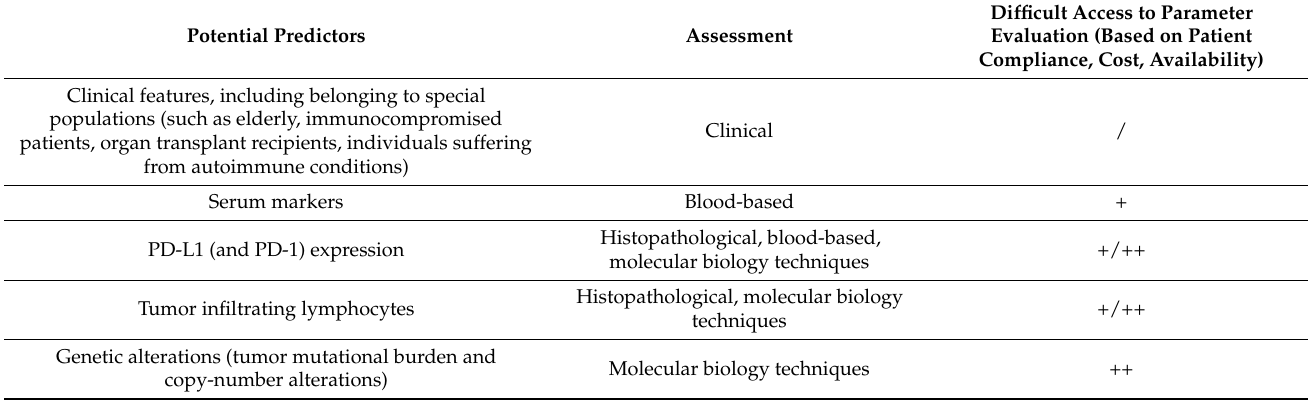
Table 6. Potential predictors to ICIs therapy in solid tumors and subdivided into different categories— starting from widely accessible to more specific